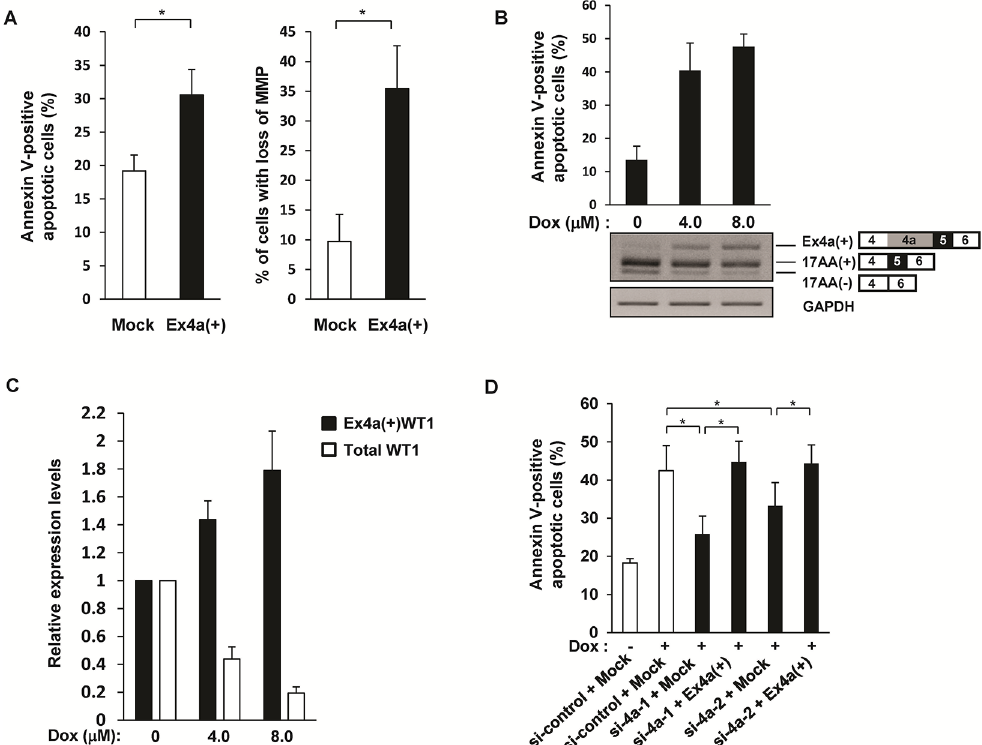
Fig 6. Apoptotic function of an Ex4a(+)WT1 isoform. ( A ) The role of Ex4a(+)WT1 in apoptosis. Ex4a(+) or Mock vector was transfected into WT1-expressing HT-1080 cells. Frequencies (%) of Annexin V-positive apoptotic cells and cells with loss of MMP were determined by flowcytometry after 24 h. Left, Frequencies (%) of Annexin V-positive apoptotic cells are shown. Right, Frequencies (%) of cells with mitochondrial membrane potential (MMP) loss are shown. Results are means and S.D. of three independent experiments. * , p < 0.05. ( B ) Expression of Ex4a(+) and major WT1 isoforms during apoptosis. K562 cells were treated with the indicated concentrations of Dox for 12 h and analyzed for Annexin-V positive apoptotic cells and expression of Ex4a(+) and major WT1 isoforms by flowcytometry and RT-PCR, respectively. Upper, Frequencies (%) of Annexin V-positive apoptotic cells. Lower, RT-PCR using Ex4-F and Ex6-R primer pair that amplifies both Ex4a(+) and major WT1 isoforms. GAPDH is used as an internal control. Results are representative of three independent experiments. ( C ) Change of Ex4a(+)WT1 and major WT1 isoforms during apoptosis. K562 cells were treated with the indicated concentrations of Dox for 12 h and expression of Ex4a(+)WT1 and total WT1 isoforms including both Ex4a(+) and major WT1 isoforms were determined by quantitative real-time RT-PCR using Ex4a-F and Ex6-R primer pair and Ex6-F and Ex7-R primer pair, respectively. Actin is used as an internal control for normalization. Expression levels of Ex4a(+)WT1 and total WT1 in Dox-untreated cells are defined as 1.0. ( D ) Suppression of Ex4a(+)WT1 inhibits Dox-induced apoptosis. K562 cells were transfected with one μ g of either of two WT1 Ex4a-specific siRNAs (si-4a-1 and si-4a-2) or a control siRNA (si- control) together with 2.0 μ g of Ex4a(+)WT1 vector or 2.0 μ g of empty vector (Mock), cultured for 24 h, treated with 4.0 μ M Dox for 12 h, and then analyzed for Annexin-V positive apoptotic cells by flowcytometry. Frequencies (%) of Annexin V-positive apoptotic cells are shown. Results are mean and S.D. of three independent experiments. * , p <